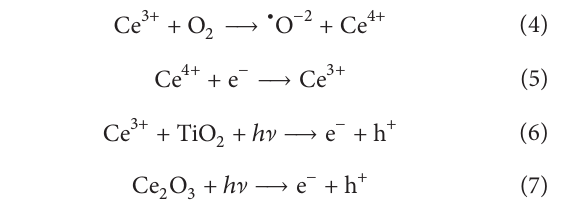
Figure 6: Degradation % of NB for different catalysts at different intensities (Conc.: 50mg L −1 , pH: 6.8, and catalyst dosage: 0.1g L −1 ).